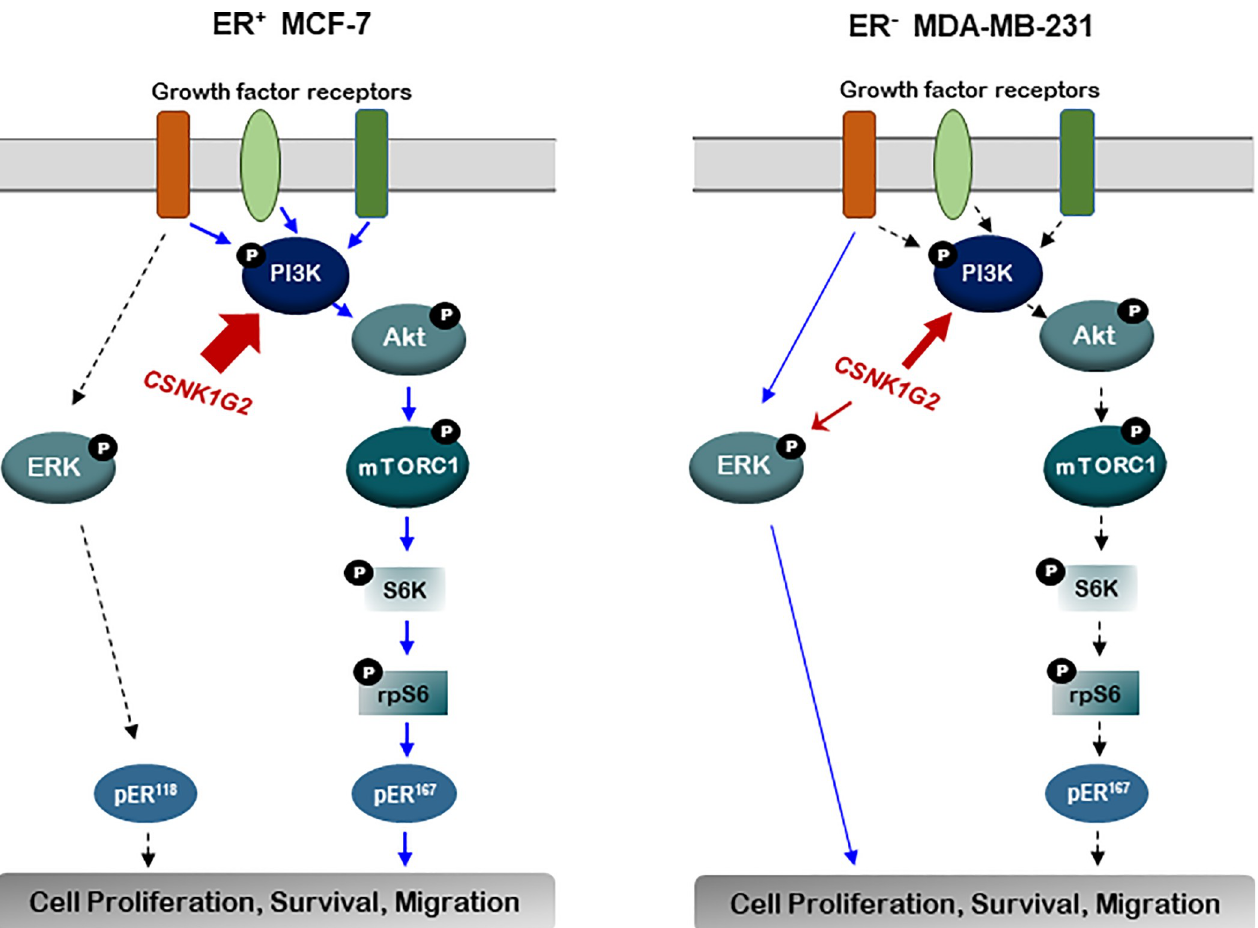
Fig 7. Schematic illustration of the CSNK1G2 -regulated PI3K/AKT/mTOR/S6K signaling pathways in TAM treated human breast cancer cells. CSNK1G2 differently influences PI3K/AKT and mTOR activity as well as S6K in ER + and ER - breast cancer cells. Red arrows represent the point of nodes altered by the CSNK1G2 , and the blue arrows indicate the intracellular signal cascades activated by CSNK1G2 . The thickness of the red arrow indicates the signal intensity. Abbreviations: PI3K , phosphatidylinositol 3-kinase; mTOR , mammalian target of rapamycin; AKT, protein kinase B; rpS6 , ribosomal protein S6; p-ER 118 , phosphorylated estrogen receptor α at Ser 118 ; p-ER 167 , phosphorylated estrogen receptor α at Ser 167 ; ERK , extracellular signal-regulated kinase; and CSNK1G2 , casein kinase 1 gamma 2